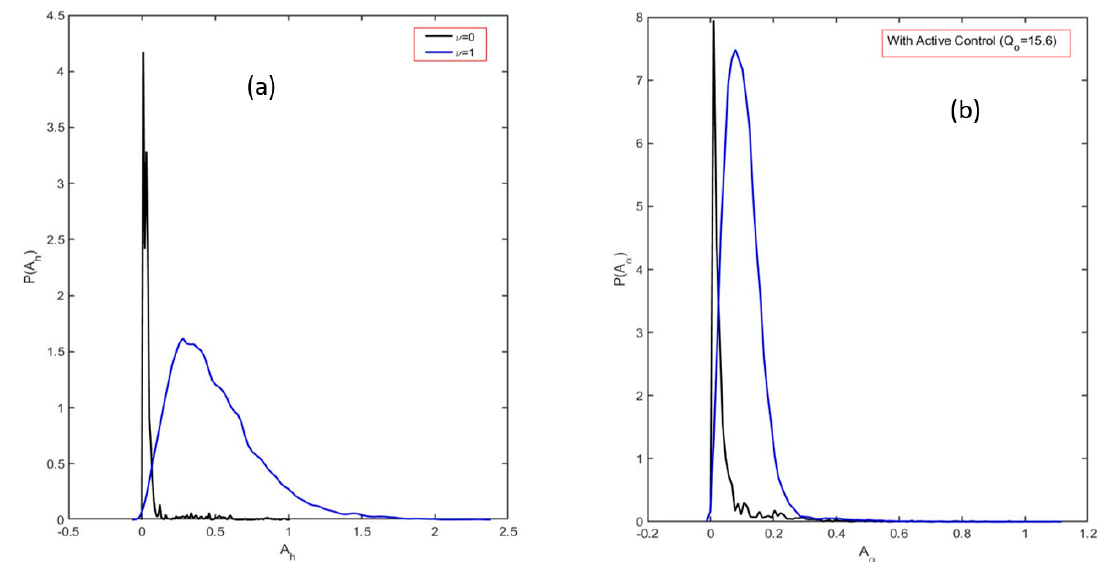
Figure 32. Probability density functions for aeroelastic displacements (closed-loop, ν = 1). ( a ) Comparison of controlled bending (h) pdfs (un-forced & with random excitation). ( b ) Comparison of controlled pitch ( α ) pdfs (un-forced & with random excitation). Random excitation under active control causes diffusion and displacement from equilibrium positions.